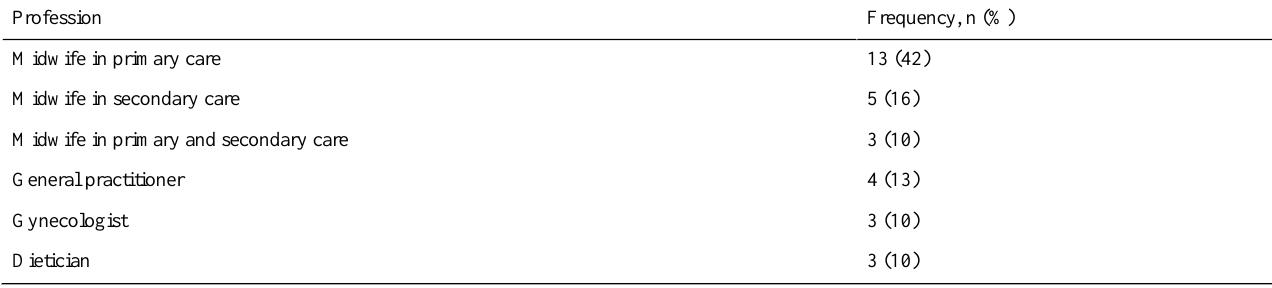
Table 1. Professions of health care providers participating in interviews and focus groups (N=31).